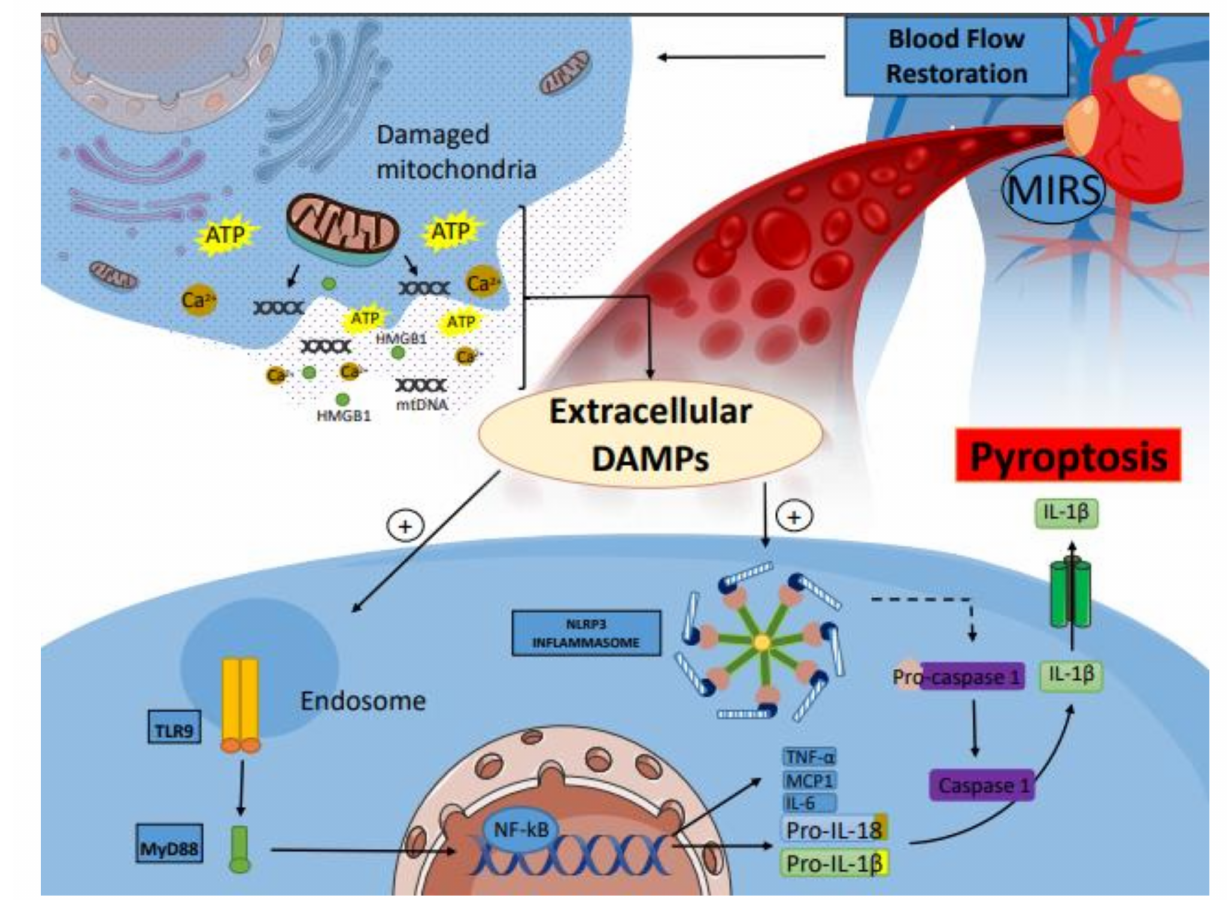
Figure 1. Inflammasome activation in MIRS. Abbreviations: DAMPs —damage-associated molec- ular patterns; HMBGB1 —high-mobility group box 1 protein; IL-1 β —interleukin-1 β ; MyD88 — myeloid differentiation primary response gene 88; MIRS —myocardial ischemia–reperfusion syn- drome; NF- κ B —nuclear factor- κ B; TLR —toll-like receptors; NLRP3 —NACHT, LRR, and PYD domain-containing protein